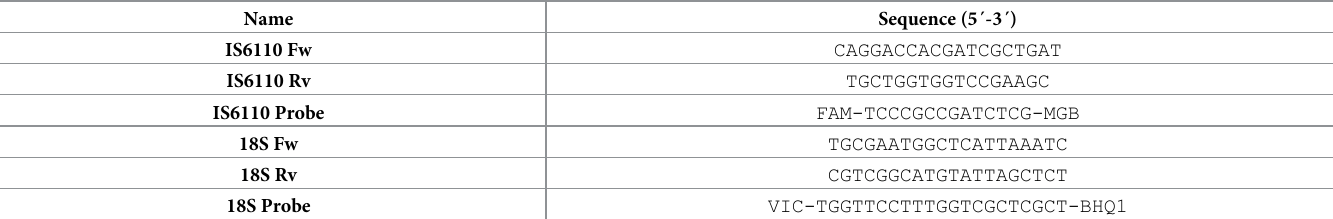
Table 3. Sequence of primers and probes used for detection of the genomic MTB target IS6110 and of the human gene 18S